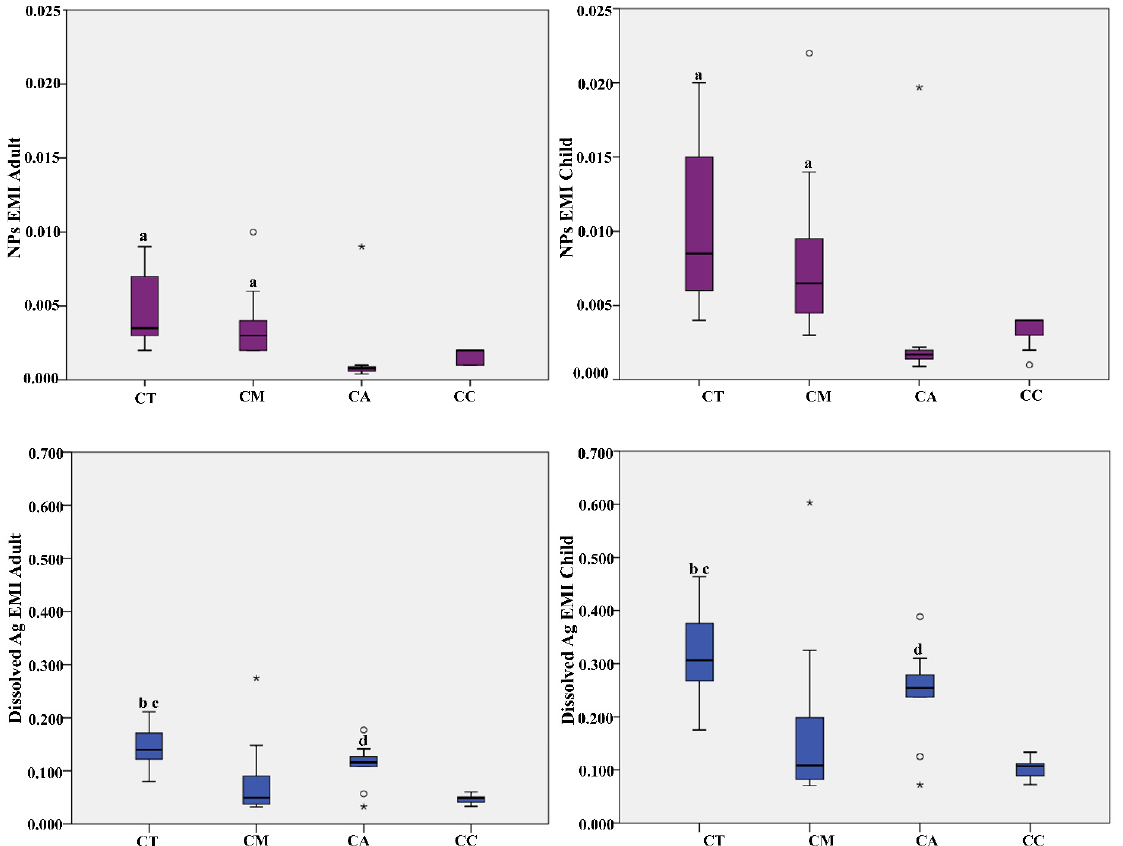
Figure 2. Box Plot distribution of Estimated Meal Intake (EMI µ g/Kg b.w.) of AgNPs and dissolved Ag concentration calculated for adult (70 years) and child (6 years). Legend: CT. Canned Tuna; CM, Canned Mackerel; CA, Canned Anchovy; CC, Canned Clam; a. p < 0.05 vs. CA and CC; b p < 0.01 vs. CM; c p < 0.001 vs. CC; d p < 0.05 vs. CC. ◦ Outliers values of the distribution. * Extreme values of the